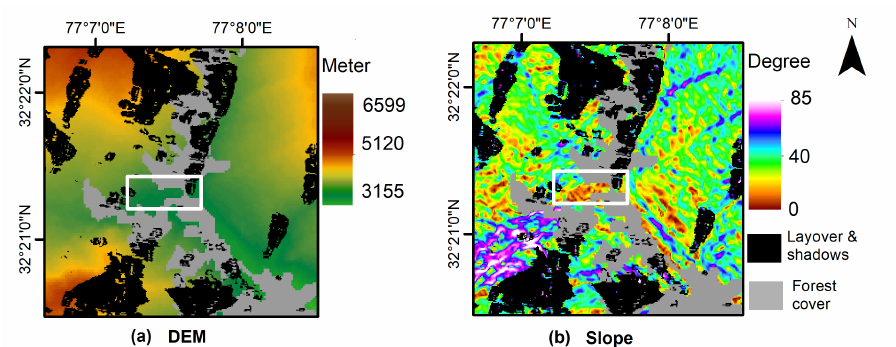
Figure 1. ( a ) SRTM digital elevation model (DEM), and ( b ) slope over study area.